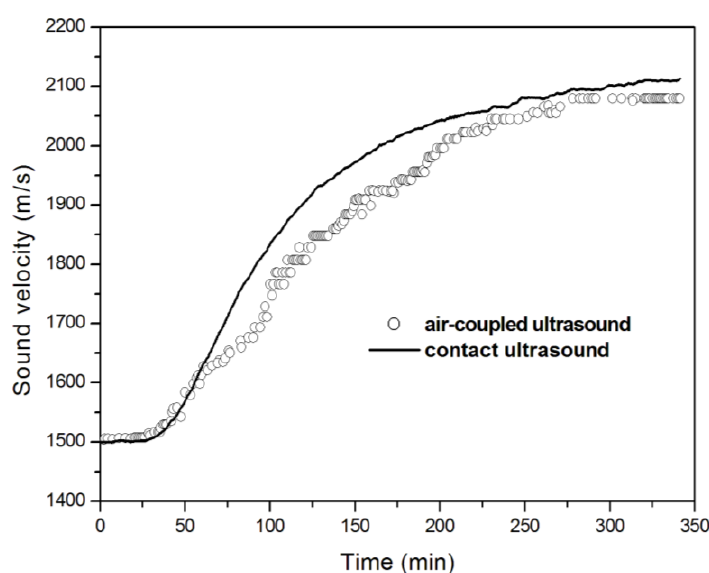
Figure 11. Comparison of longitudinal velocity changes, obtained both by air-coupled (0.5 MHz) and contact (2 MHz) transmission mode, during the cure at room temperature of an unsaturated polyester resin (adapted from